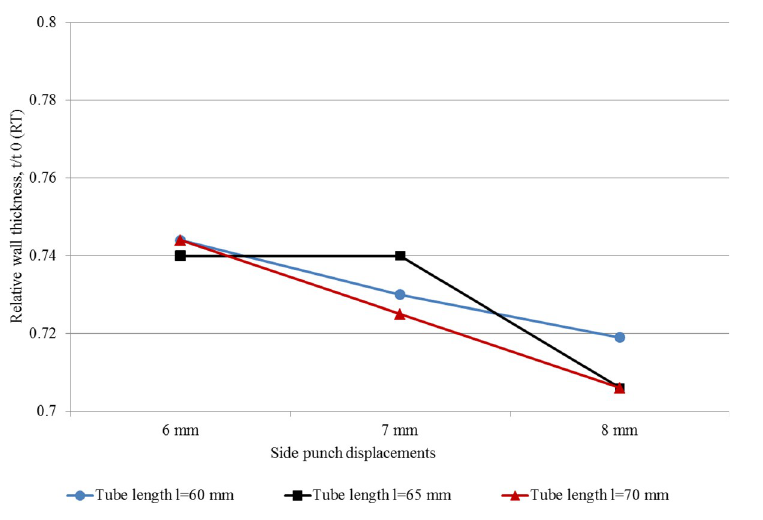
Fig 12. Experimental results of minimum